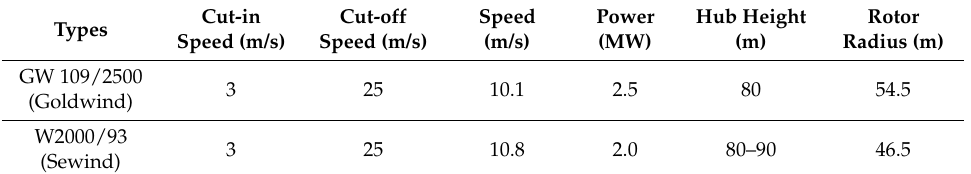
Table 4. Main parameters of the wind turbine installed in XIPP,